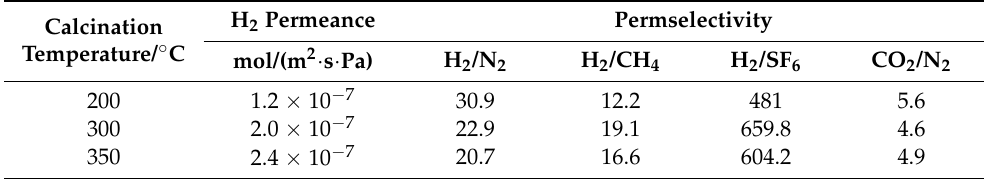
Figure 5. Gas permeance tested at 200 °C for BTESE-PNEN membrane calcinated at 200, 300 and 350 °C. Table 1. Gas permeance and permselectivity at different calcination temperatures.